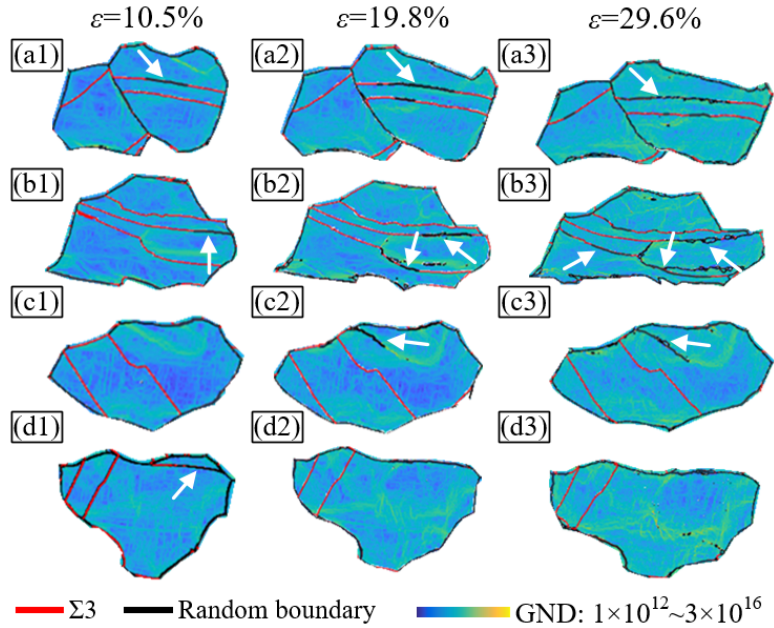
Figure 6. The GND distribution of grain groups ( a1 – a3 ) GGI, ( b1 – b3 ) GGII, ( c1 – c3 ) GGIII, and ( d1 – d3 ) GGIV at strain values of 10.5%, 19.8%, and 29.6%, respectively.